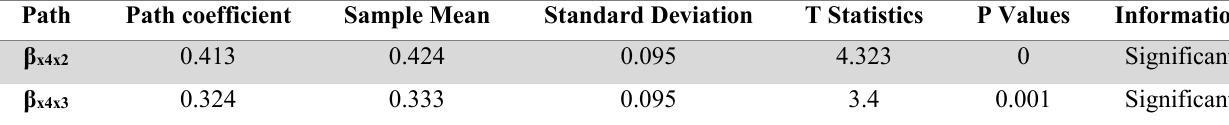
Results of Calculation and Testing of Path Coefficients Model 2